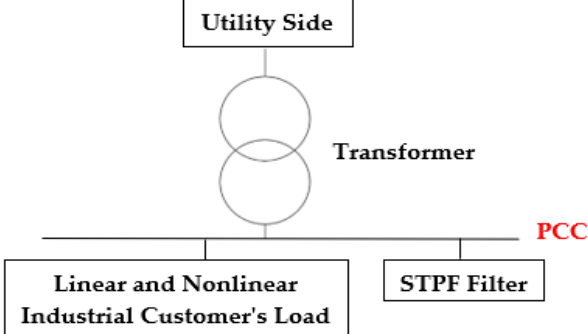
Figure 2. Single-line diagram representation of the emulated system (after [23]).